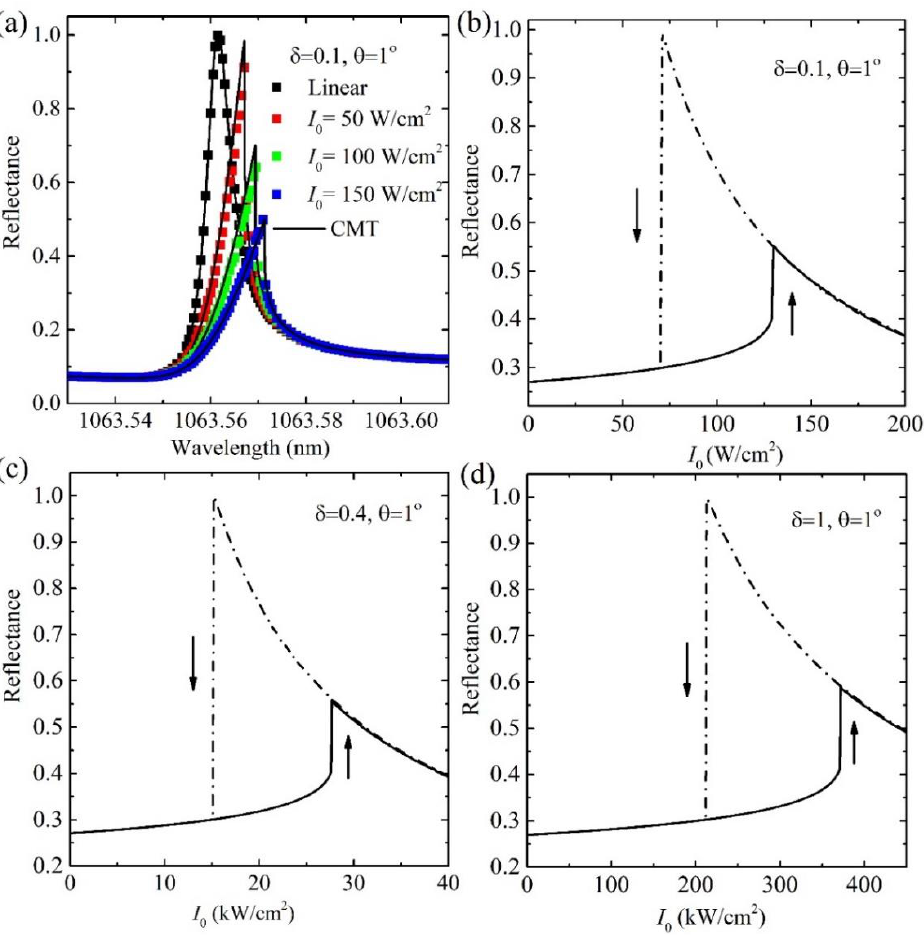
Figure 3. ( a ) Linear reflectance spectra under different input intensity in GMR structures of δ = 0.1 at θ = 1°. Optical bistability of linear reflectance in GMR nanostructures of different ( b ) δ = 0.1, ( c ) δ = 0.4 and ( d ) δ = 1 at θ = 1°, respectively. ( c ) δ = 0.4 and ( d ) δ = 1 at θ = 1 ◦ ,